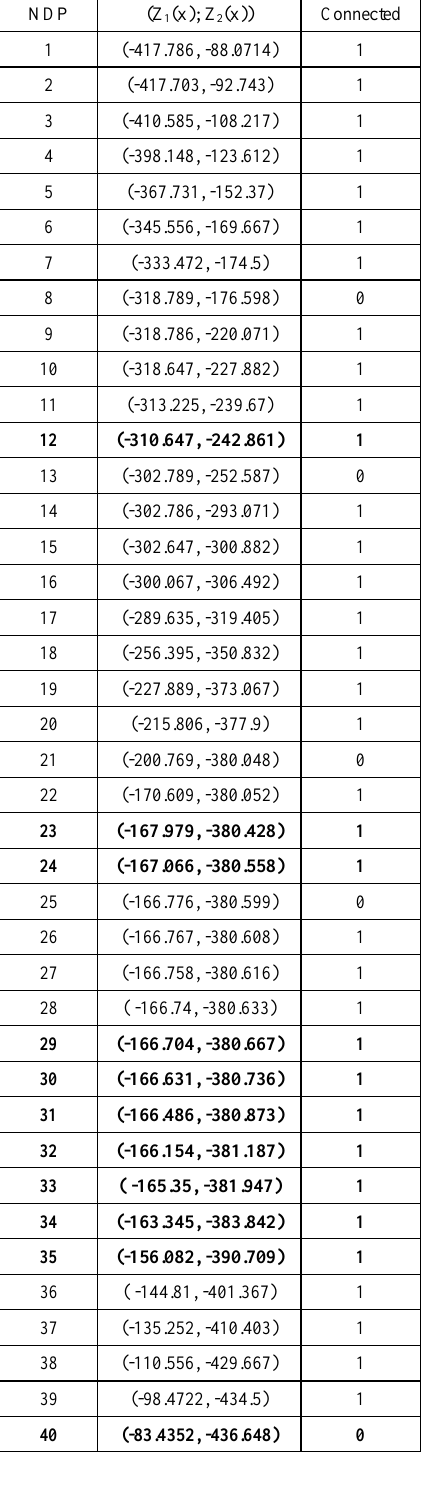
Table 4. Nondominated frontier points for first instance Boland et al. (2015) solved by